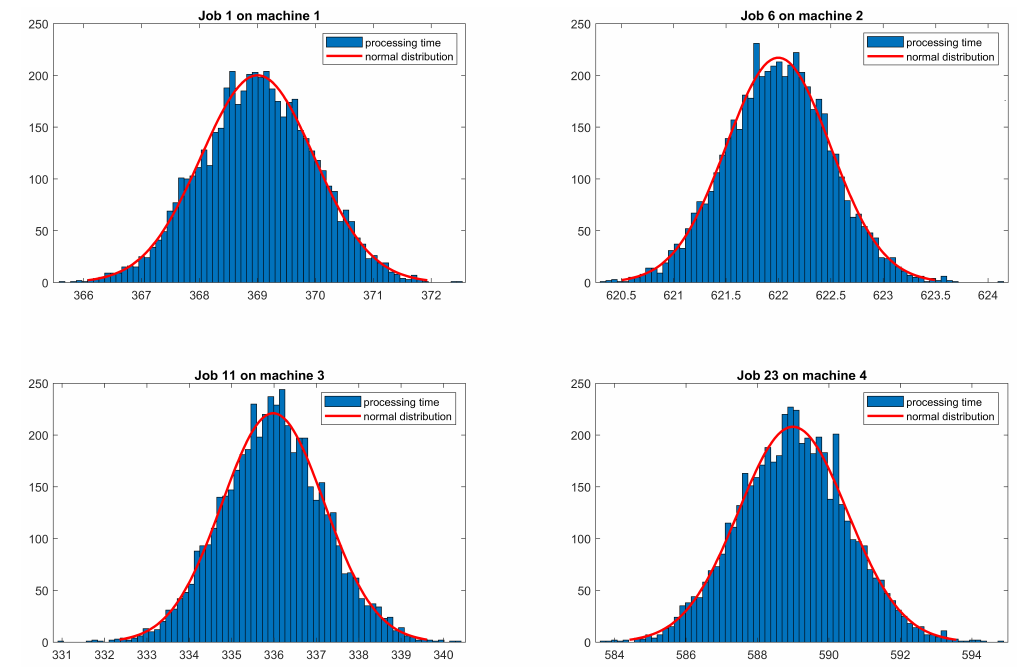
Figure 11. Example of job processing time